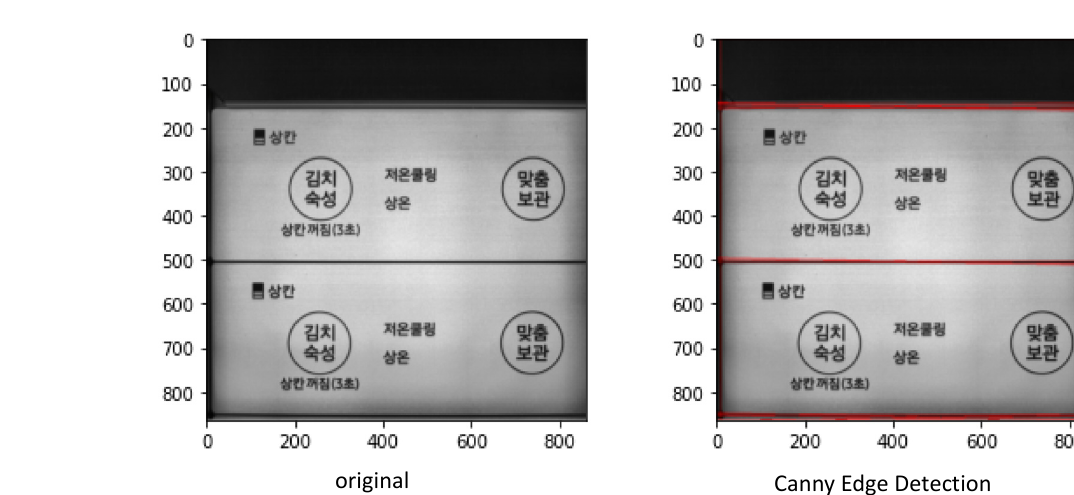
Figure 12. Canny edge detection example.